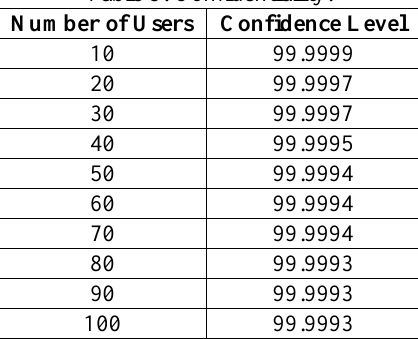
Table 3: Confidentiality.